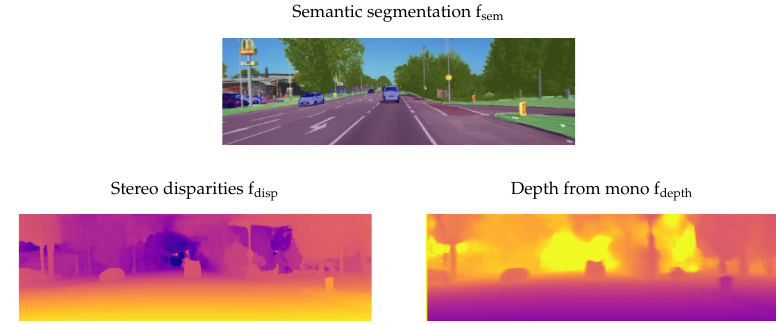
Figure 6. Results of the three neural networks used to generate the input images for our proposed grid mapping